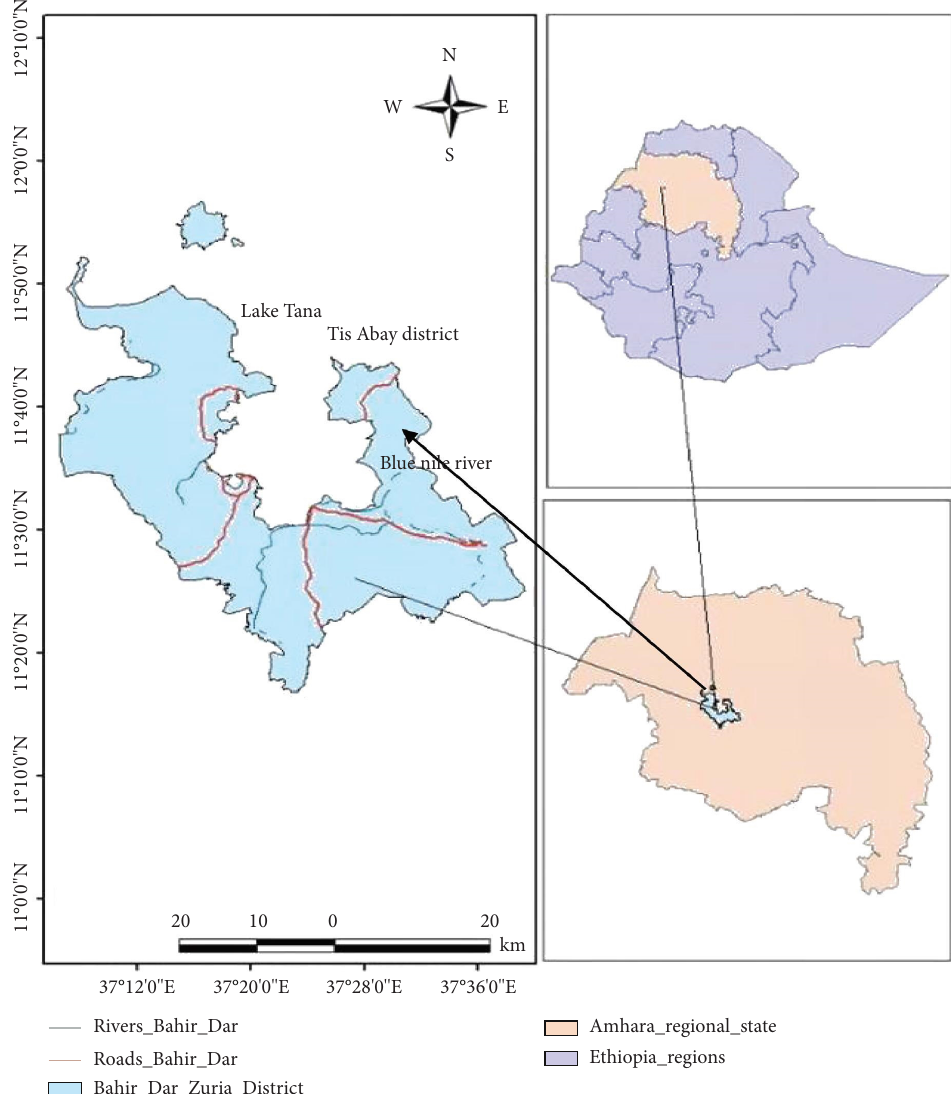
Figure 1: Map of the study area, ArcGIS software,